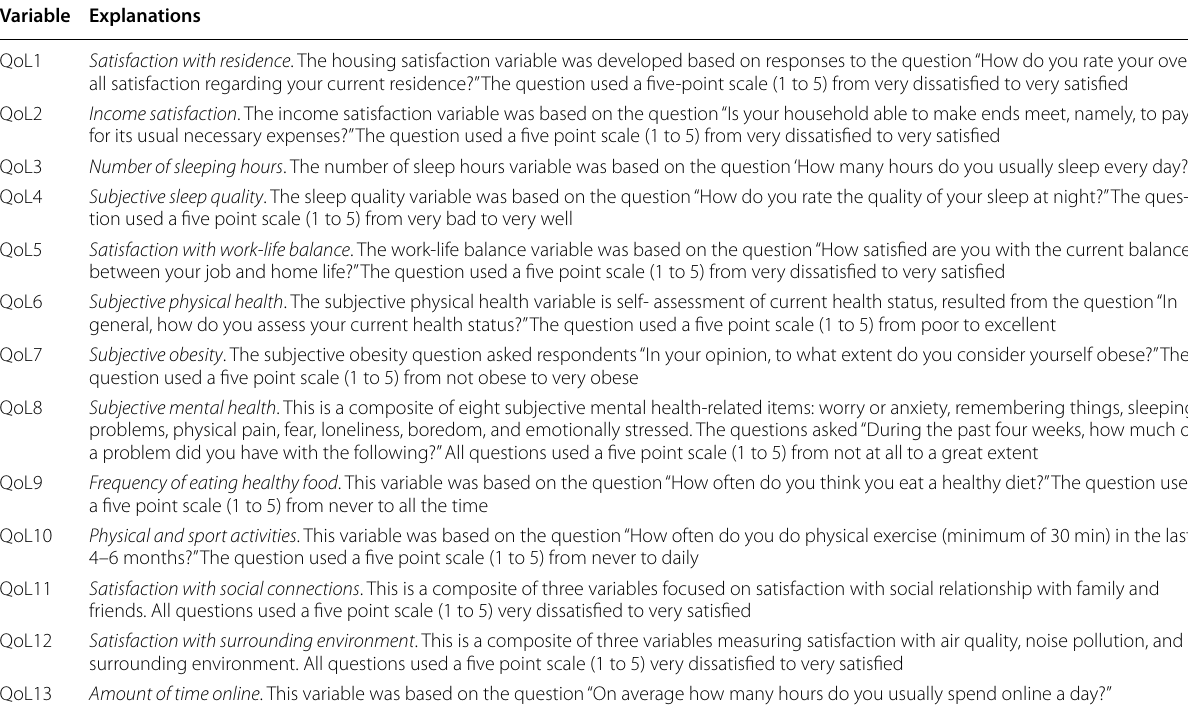
Table 1 Variables used in the path model Variable Explanations QoL1